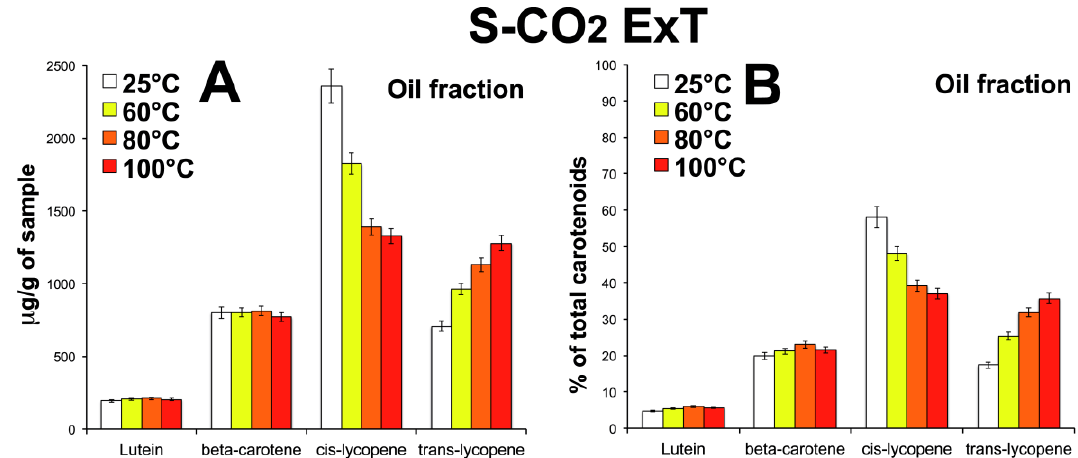
Figure 6. Effect of temperature on the carotenoid composition. Oil fractions ( A , B , E , F ) and insoluble fractions ( C , D , G , H ) of the oleoresin S-CO powder ( A , B , C , D ) and of the oleoresin S-CO powder ( E , F , G , H ). Values are expressed as mg per gram of sample ( A , C , E , G ) and as percentage of the total carotenoids ( B , D , F , H ). Data are mean ± SD of three measures from three independent samples ( n =